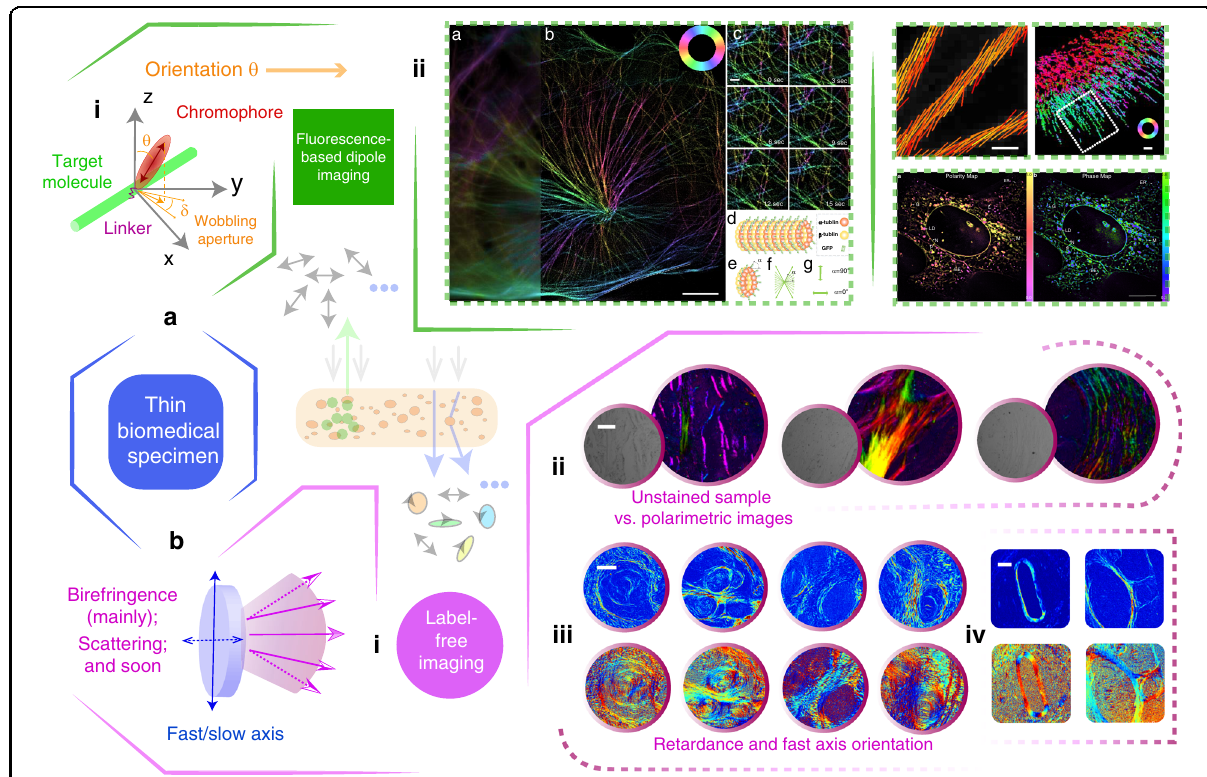
Fig. 6 Two categories of the applications enabled via thin specimen polarimetry. a (i) Model of the dipole and target molecule with linker- related fundamental mechanism can be found in refs. 154,155 . (ii) Fluorescence dipole orientation imaging 181,182,233,289 . The polarisation orientation is given as a demonstration. b (i) Model of the main properties in thin specimen for label-free polarimetric imaging. (ii) Unstained/polarimetric imaging of human cervical and liver carcinoma tissue samples 32 . (iii) Polarimetric parameters imaging results to distinguish between Crohn ’ s disease and gastrointestinal luminal tuberculosis tissues 164 . (iv) Polarimetric parameters images of human liver cirrhosis samples in different stages 163 . (a(ii) besides upper-right) Adapted with permission from refs. 181,182 . CC BY 4.0. (a(ii); upper-right) Adapted from refs. 233,289 . (b(ii) and b(iv)) Adapted from refs. 32,163 . CC BY 4.0. (b(iii)) Copyright Wiley-VCH GmbH. Reproduced with permission ref.